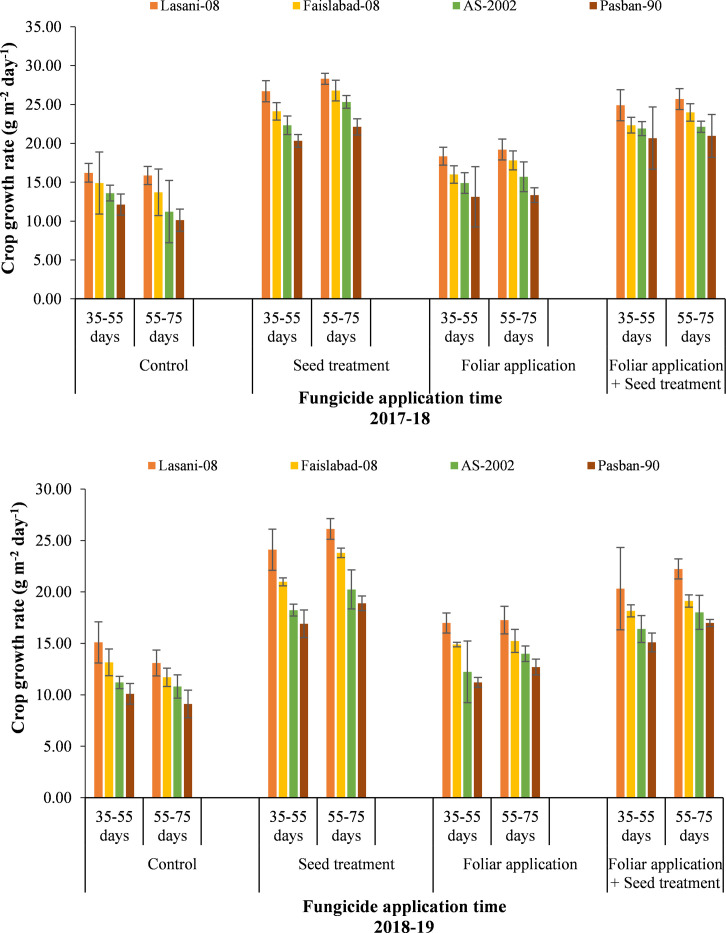
The influence of different fungicide application timings on crop growth rate of wheat cultivars with varying tolerance to Karnal bunt disease.